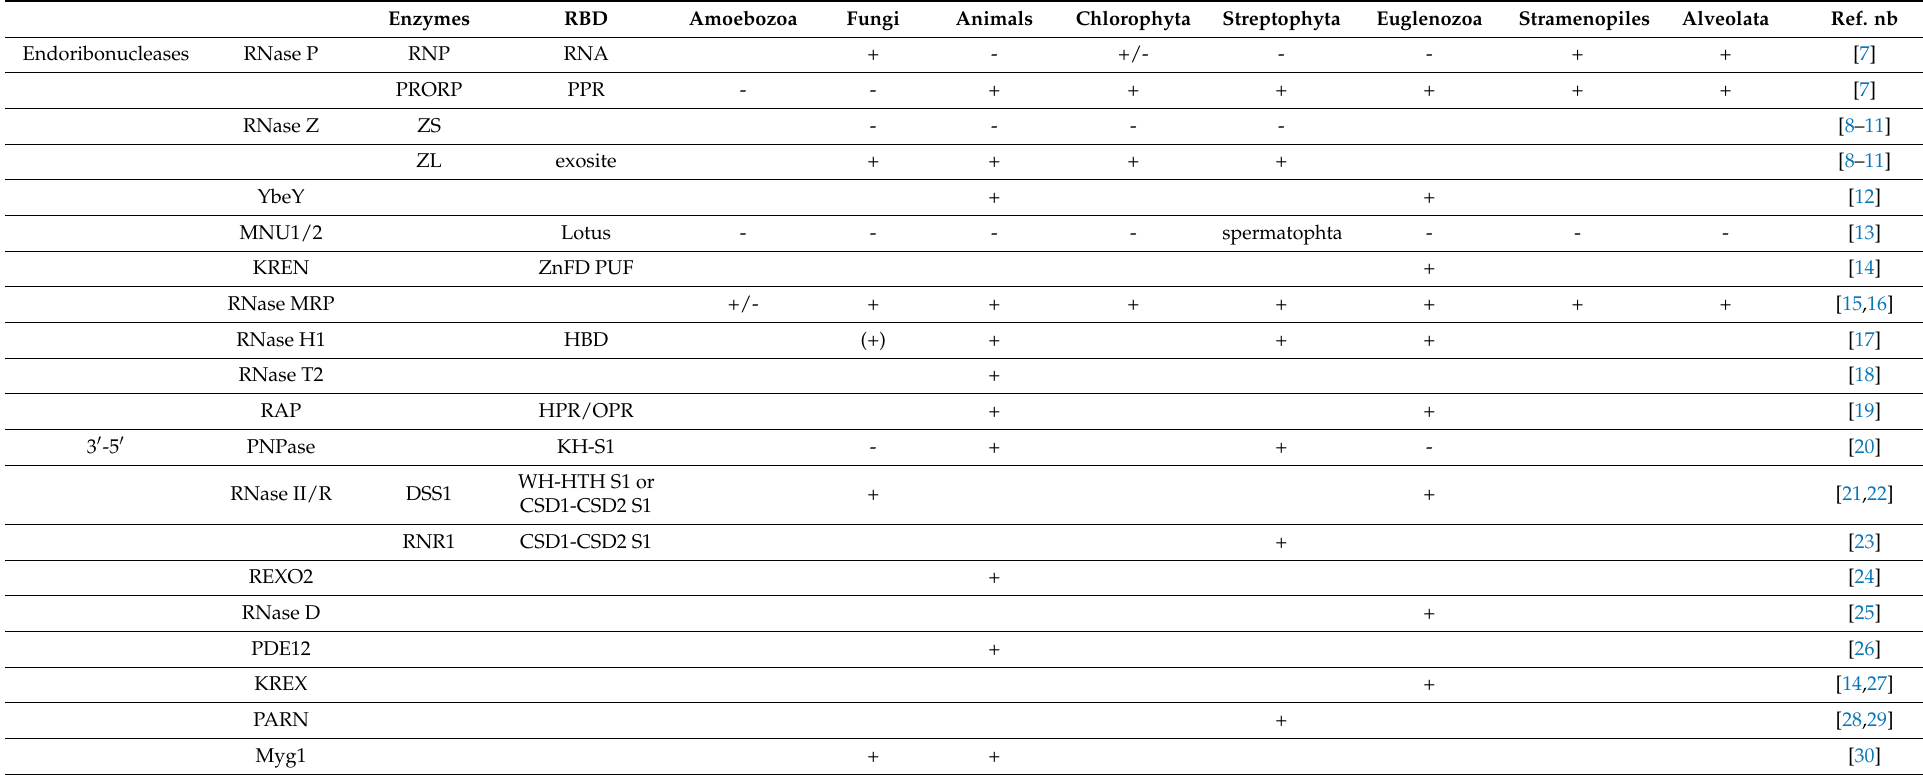
Table 1. Occurrence in the mitochondria of the different types of RNases in representative phyla of the eukaryotes. The presence (+), absence (-) of each type of enzyme, as well as the absence of information in the literature ( ), are all listed for the following phyla: Amoebozoa, Opisthokonta (Fungi and Animals), Archaeoplastida (Chlorophyta, Streptophyta, i.e., green algae and land plants), Euglenozoa (clade where trypanosomatids are found), as well as Stramenopiles (brown algae, diatoms, oomycetes, . . . ) and Alveolata (Plasmodium, Dinoflagellates, . . . ). The results presented in this table reflect state-of-the-art literature (reference numbers in the last column), not a de novo phylogenetic analysis of the occurrence of ribonucleases across eukaryotes. Ref. nb: reference